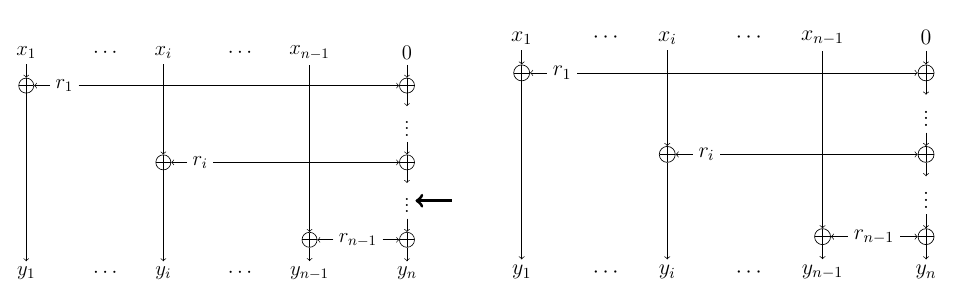
Figure 3: Illustration of Lemma 3. Case 1 (left): the adversary has spent at least one probe on the last column for which x n = 0, therefore we can have | J | ≤ t − 1. Case 2 (right): no intermediate variable is probed on the last column; therefore r i can play the role of a one-time pad for the simulation of the outputs y i for any i ∈ O ∩ [1 , n − 1]. input share x n of RefreshMasks is such that x n = 0 (as it is the case in Algorithm 3 at Line 9), then we can get the improved condition I = ( O ∩ [1 , n − 1]) ∪ J with | J | ≤ t − 1, instead of I = O ∪ J with | J | ≤ t as in Lemma